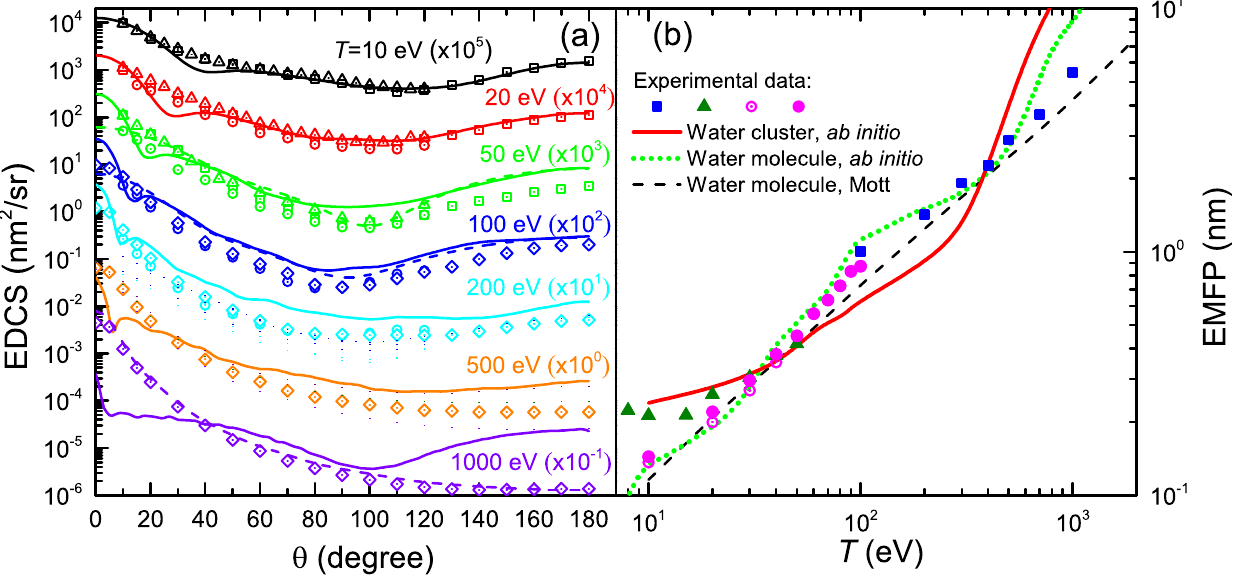
Figure 6. ( a ) Elastic singly differential cross sections (EDCS) of electrons of energy T scattered by water molecules and a water cluster. Solid lines correspond to ab initio calculations for a cluster of six water molecules [43], while dashed lines are Mott theory calculations for a single water molecule. Symbols are experimental data for water vapour [117] (squares), [118] (circles), [119] (triangles) and [120] (diamonds). ( b ) Elastic free path (EMFP) for electrons in water, as a function of electron energy T . Ab initio calculations are shown by a red solid line for a cluster of six water molecules [43], by a green dotted line for one water molecule, and by a black dashed line for Mott theory calculations for a water molecule. Symbols represent experimental data for water vapour: [120] (squares), [117] (triangles), [24] (empty circles) and [27] (full